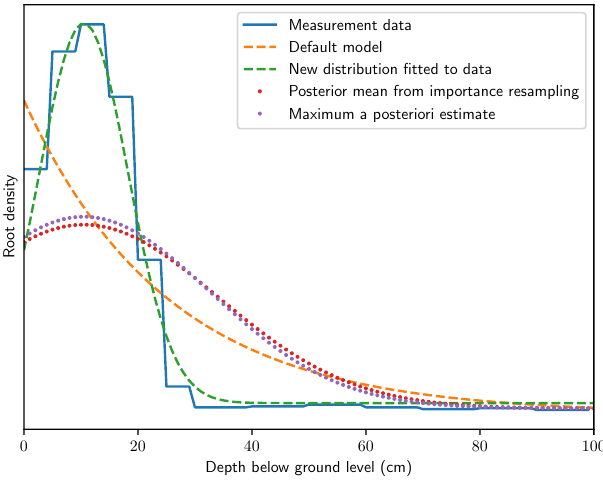
Figure 1. The different root distribution descriptions. The original description is shown as the decaying exponential, and the graph with discrete steps shows measurement data from Saarinen (1996). The new root distribution curve with optimized parameters is shown along with the curves resulting from the MCMC optimization. The original distribution gives more root mass to depths of 50–80cm than the MCMC-optimized curves of the new root distribution. All curves are normalized to the same total root